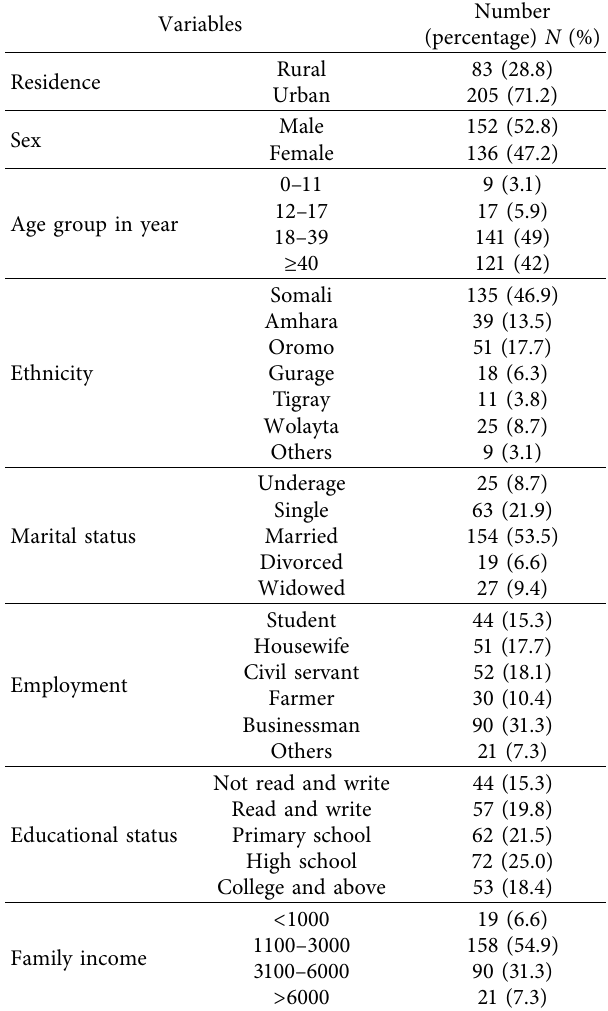
Table 1: Sociodemographic characteristics of the study participants with external ocular infections attending at Karamara hospital, Jigjiga, eastern Ethiopia,